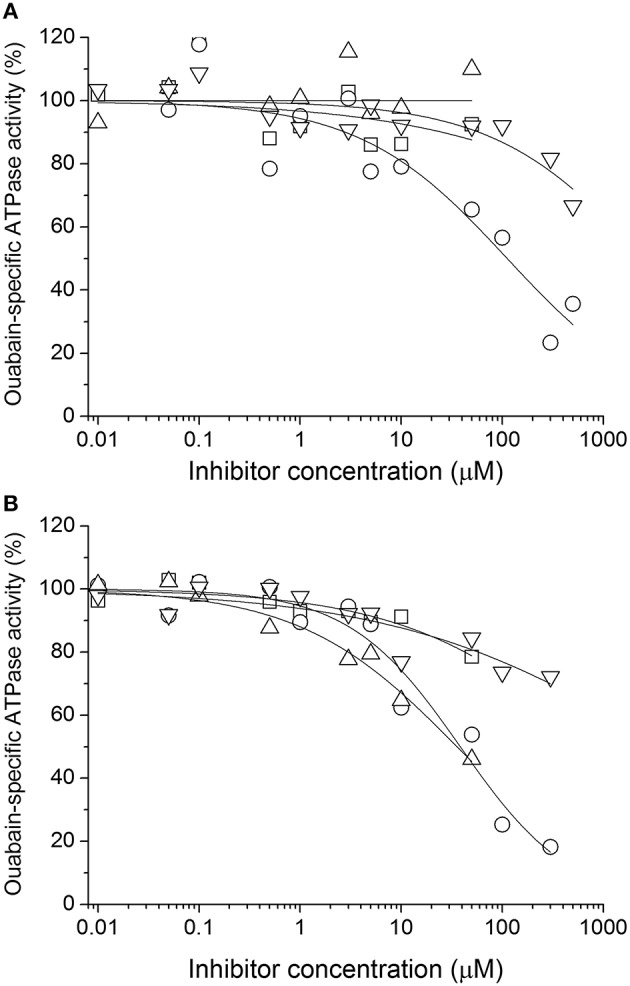
Inhibition of NKA by (A) SB (squares), SCH (circles), SD (up triangles), TAX (down triangles) and (B) by the corresponding dehydro- derivatives DHSB, DHSCH, DHSD and QUE. The reference value (100%) represents ouabain-specific activity of untreated NKA.